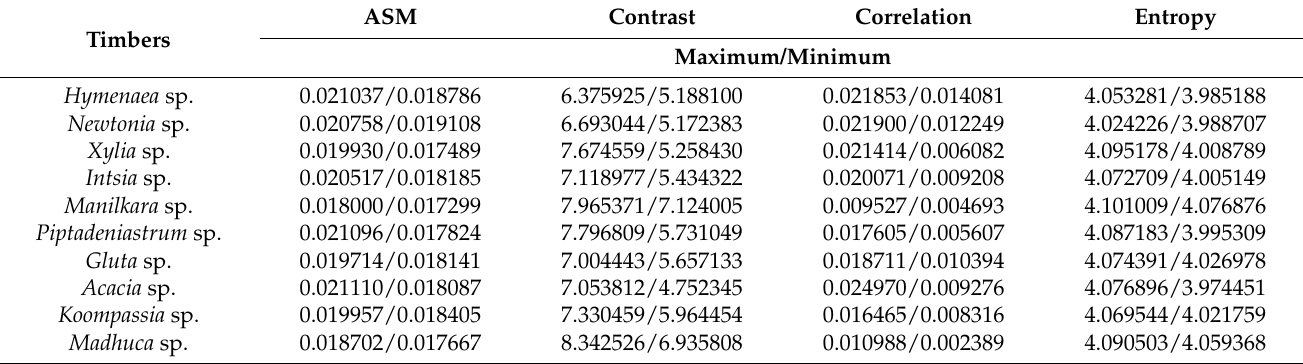
Table 2. GLCM textural features on the transverse surface of the first 10 wood samples. ASM Contrast Correlation Timbers